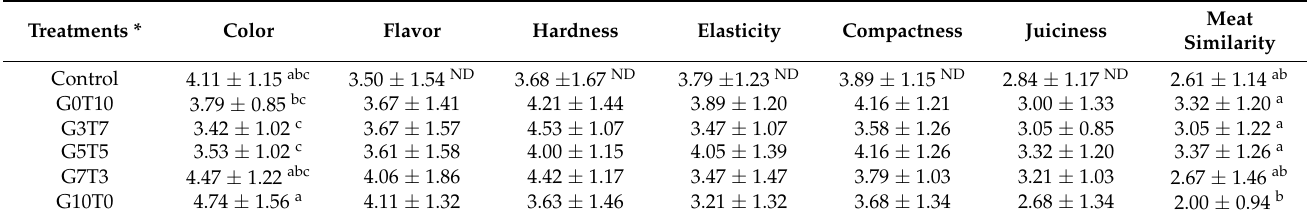
Table 4. Intensity of sensory properties of PBMPs with different binders.